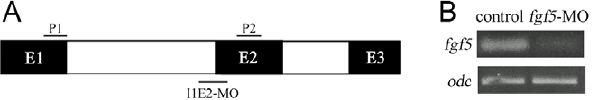
Figure 5. Efficacy of fgf5 splice-blocking MO. (A) Schematic of fgf5 mRNA showing intron-exon structure (not to scale). Binding sites for splice-blocking morpholino at intron1-exon2 junction (I1E2-MO) and PCR primers for RT-PCR (forward P1, reverse P2) are shown. (B)